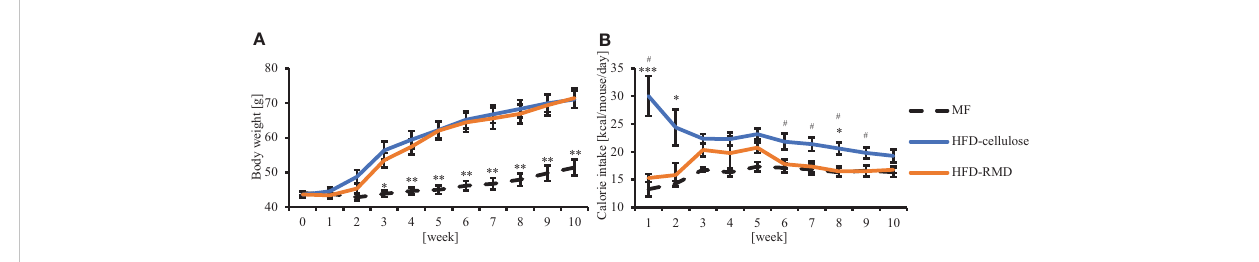
FIGURE 2 Effects of resistant maltodextrin (RMD) on body weight and caloric intake. Changes in average (A) body weight and (B) caloric intake. (MF, n = 7; HFD-celllose, n = 8; HFD-RMD, n = 6). Data are shown as means ± standard error of the mean (SEM). * p < 0.05, ** p < 0.01, *** p < 0.001 vs the HFD-RMD group (Kruskal-Wallis test with Dunn ’ s multiple comparisons test). # p < 0.05 vs the HFD-RMD group (Mann Whitney